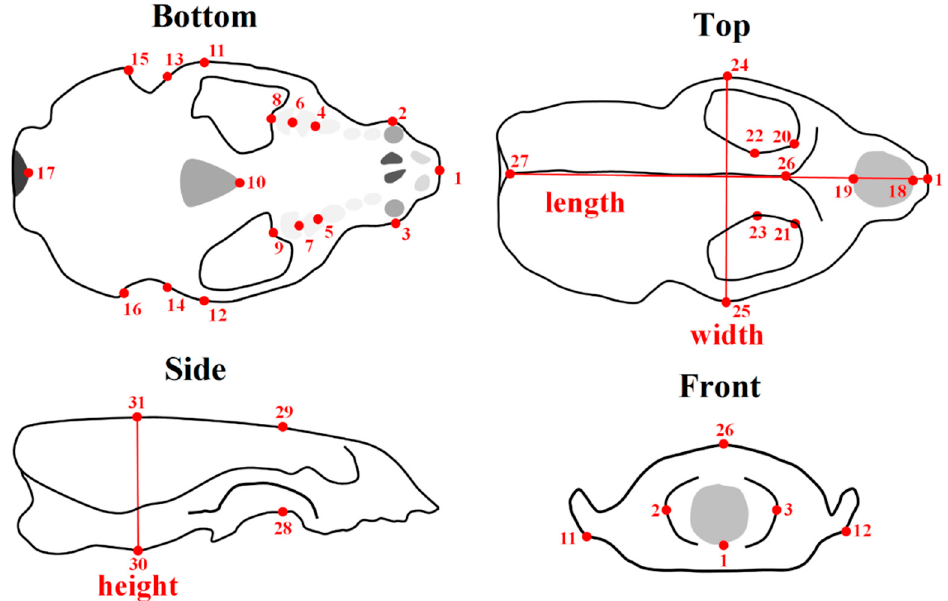
Figure 2. Schematic of the upper part of an otter cranium from different viewpoints with 31 landmark points indicated. Distances, such as the length, width, and height, of the skull can be found using these landmark points placed by using a graphical user interface (GUI) (referred to as “GUI-based” distance measurements). These distances were also measured directly for the crania by using a digital caliper (referred to as “physical” distance